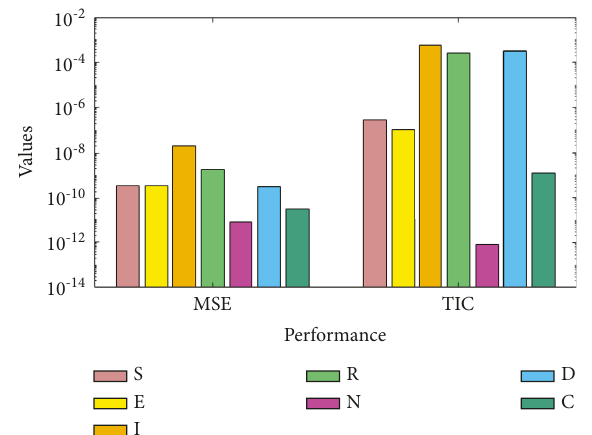
Figure 5: Statistical performances for the mathematical SEIR-NDC system.